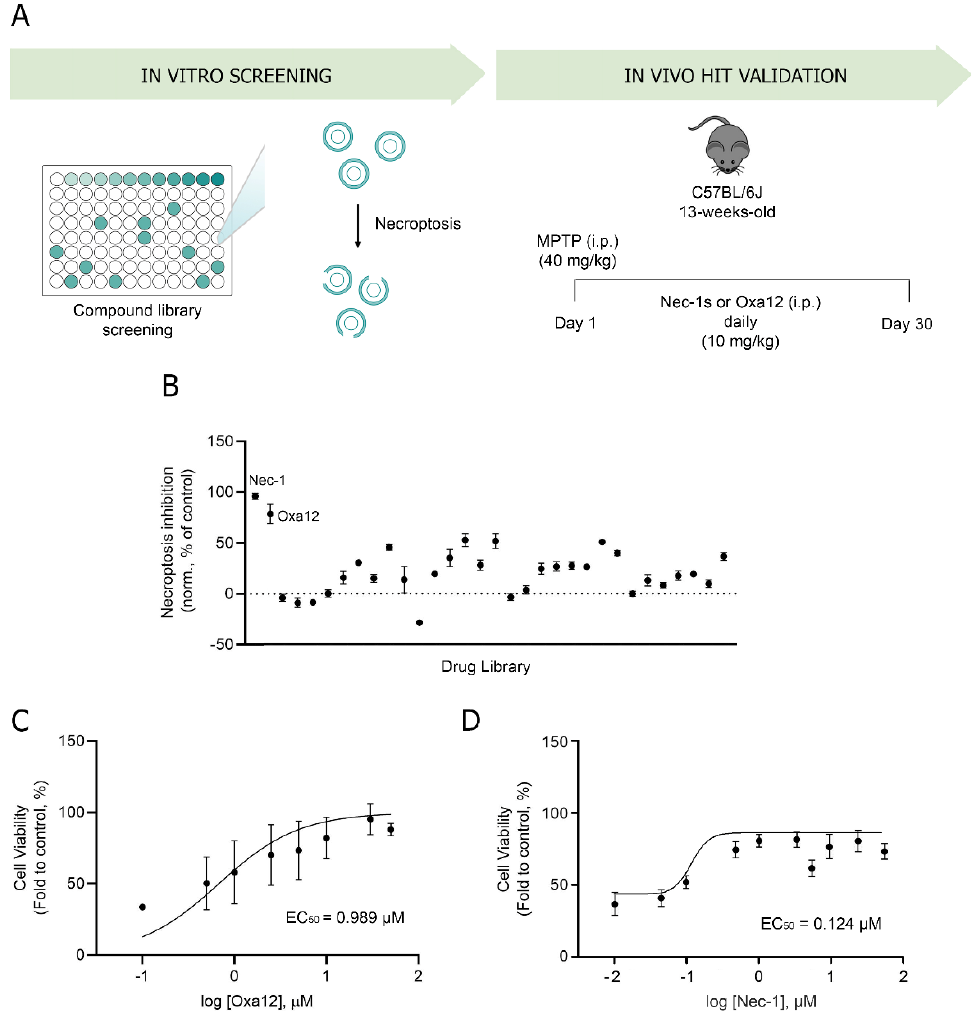
Figure 1. A cell-based phenotypic screening identifies Oxa12 as a necroptosis inhibitor. ( A ) Schematic overview of the two-step screening workflow. ( B ) Determination of the ability of the compound to inhibit necroptosis. Cell metabolic activity is depicted as a percentage of the control (DMSO = 0; Nec-1 at 30 µM) for compounds at 30 µM tested in BV2 murine microglia cells exposed to 25 µM zVAD-fmk for 24 h. ( C ) Half-maximal effective concentration (EC 50 ) determination in BV2 murine microglia cells in a dose-response concentration (0.1 to 50 µM Oxa12) plus 25 µM zVAD-fmk for 24 h. ( D ) Half-maximal effective concentration (EC 50 ) determination in BV2 murine microglia cells in a dose-response concentration (0.01 to 50 µM Nec-1) plus 25 µM zVAD-fmk for 24 h.